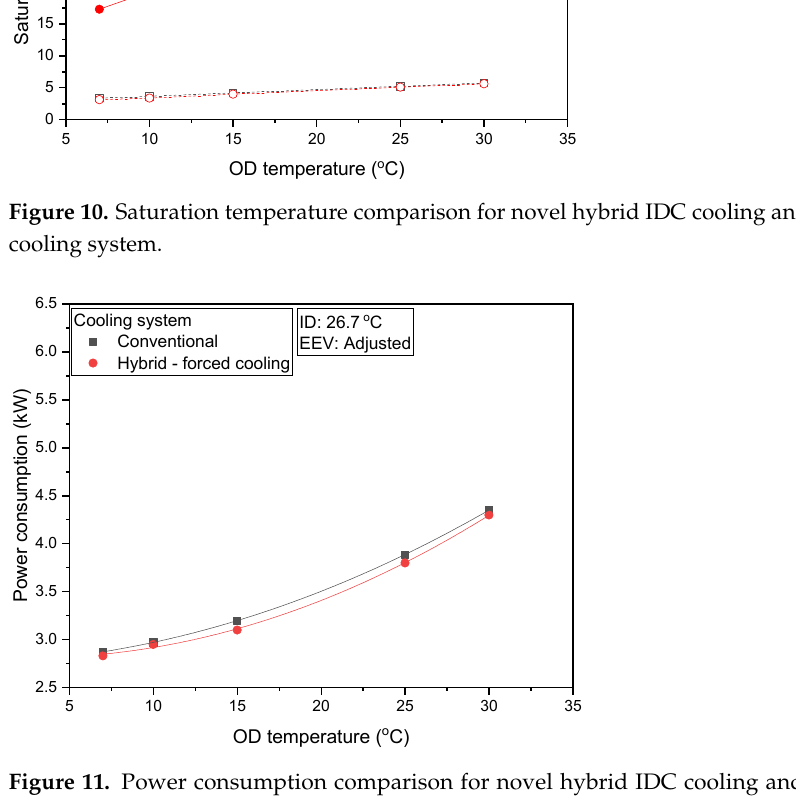
Figure 11. Power consumption comparison for novel hybrid IDC cooling and conventional IDC cooling system.